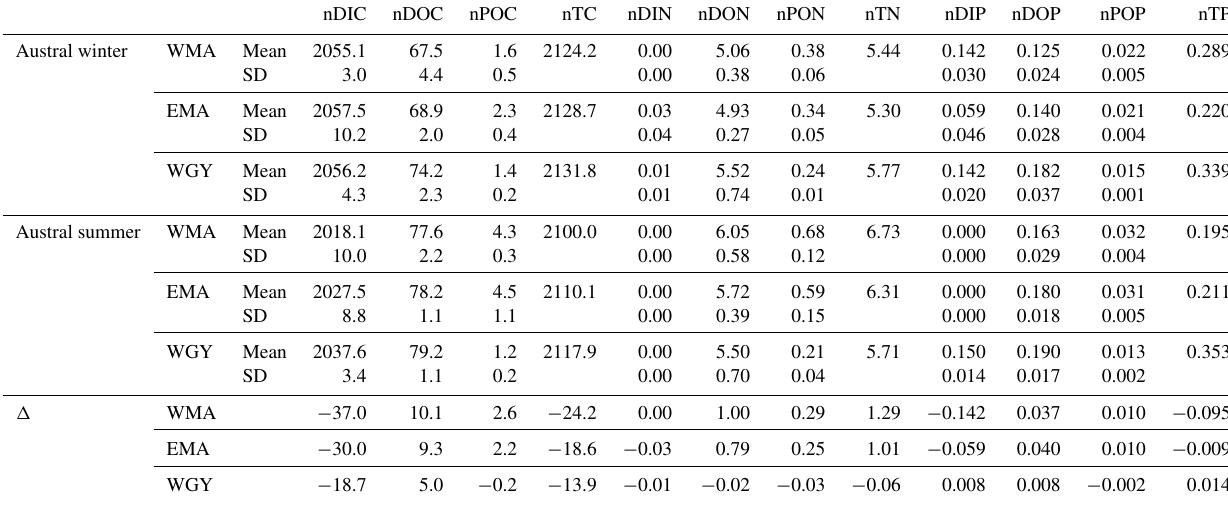
Table 7. Estimated temporal evolution of surface biogeochemical properties between austral winter (up) and summer (below) in µmolL − 1 presented in columns: (1) Mean measurements at 70m depth during OUTPACE were considered to represent the homogeneous upper water column (0–70m) variables and initial winter conditions (i.e., conditions in July 2014). The summer conditions were those observed during the OUTPACE cruise (March 2015). (cid:49) represents the summer minus winter condition differences. (2) Selected area: western Melanesian Archipelago (WMA), eastern Melanesian Archipelago (EMA), or western gyre (WGY). (3) Mean or standard deviation (SD), (4 to 15) dis- solved inorganic (DI), dissolved organic (DO), particulate organic (PO), and total (T) C, N, and P, respectively. All variables were normalized to the mean absolute salinity measured at 70m depth to discard evolution due to evaporation or precipitation.